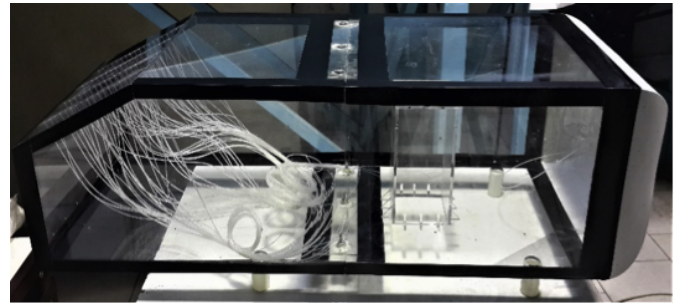
Figure 7. Picture of the Ahmed body used in